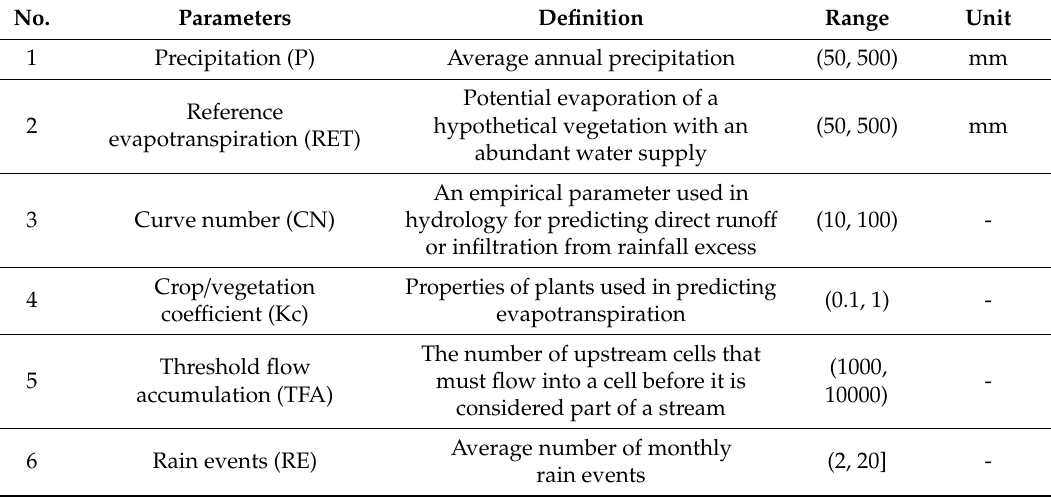
Table 1. Variation range of model inputs in the sensitivity